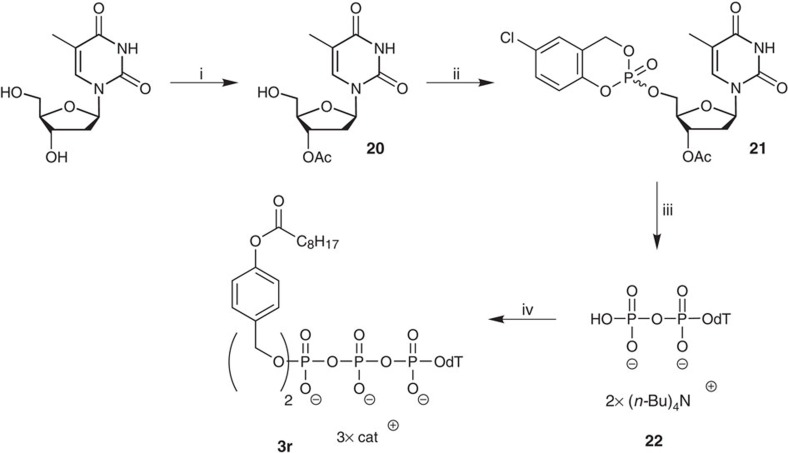
Reagents and conditions.(i) 1. TBDMSCl, pyridine, rt, 20 h, 2. Ac2O, rt, 5 h, 3. TBAF, THF, 0 °C, 1.5 h; (ii) 1. 5-chlorosaligenylchlorophosphite 8, N,N-diisopropylethylamine, CH3CN, 0 °C-rt, 3 h, 2. t-BuOOH in n-decane, 0 °C, 20 min; (iii) 1. (H2PO4)Bu4N, DMF, rt, 20 h, 2. MeOH/H2O/Bu4NOH (7:3:1), rt, 17 h; (iv) 1. 5e, DCI, CH3CN, rt, 1 min; 2. t-BuOOH in n-decane, 0 °C-rt, 15 min.